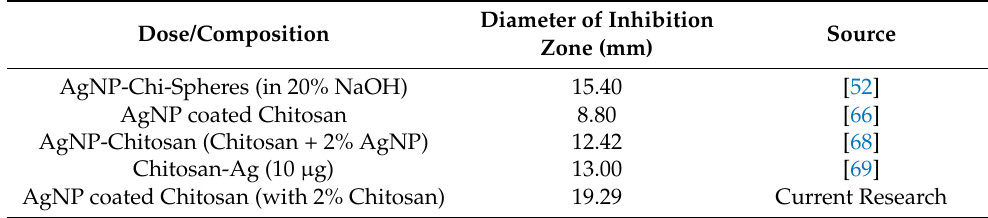
Table 4. Comparison of antibacterial activity of silver nanoparticles coated with chitosan against S. aureus bacterial strain for previous and current